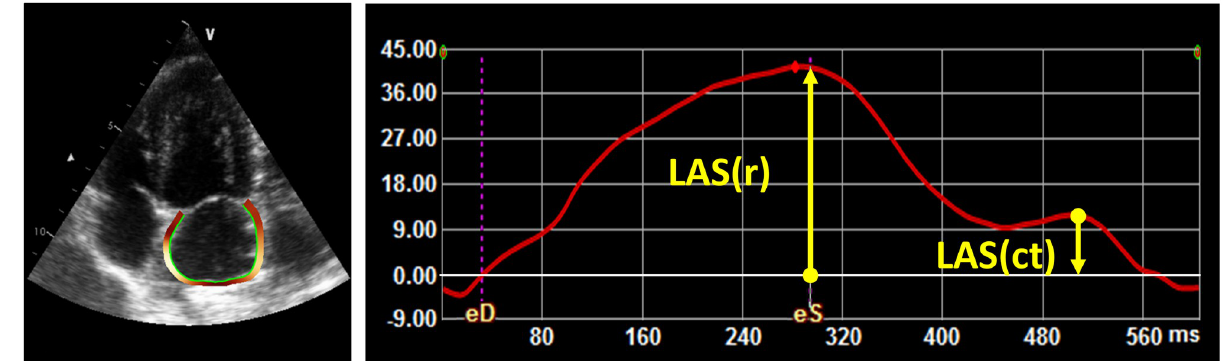
Fig 2. Example of LA strain assessment by 2D speckle-tracking echocardiography at baseline. Four-chamber longitudinal left atrium strain (LAS). Arrows represent reservoir (r) and contractile (ct) phase (42% and -12%, respectively).